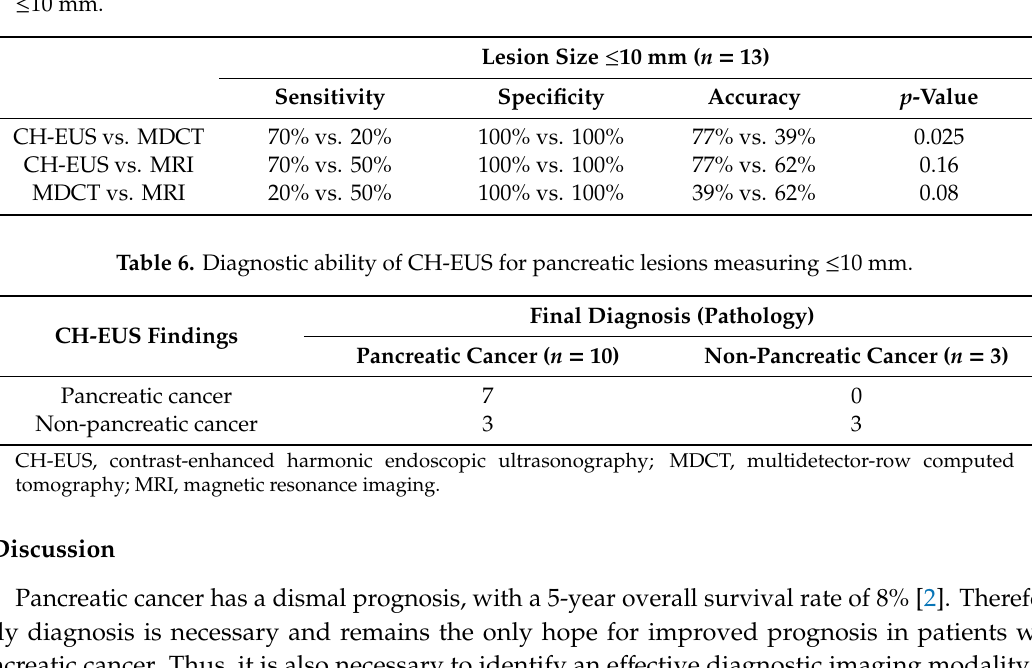
Table 5. Diagnostic ability of three modalities (CH-EUS, MDCT, MRI) for pancreatic lesion measuring ≤ 10 mm.